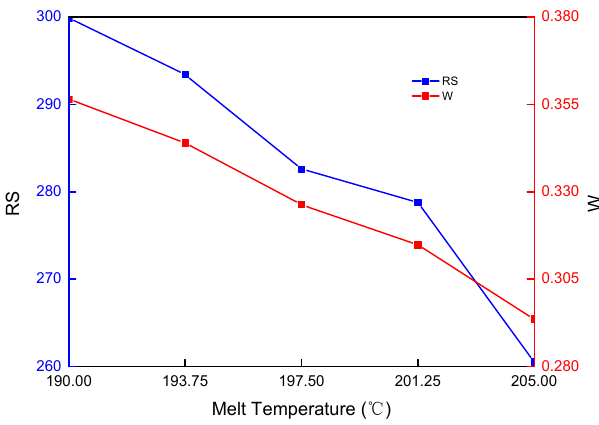
Figure 11. The effect of melt temperature on the residual stress and warpage.